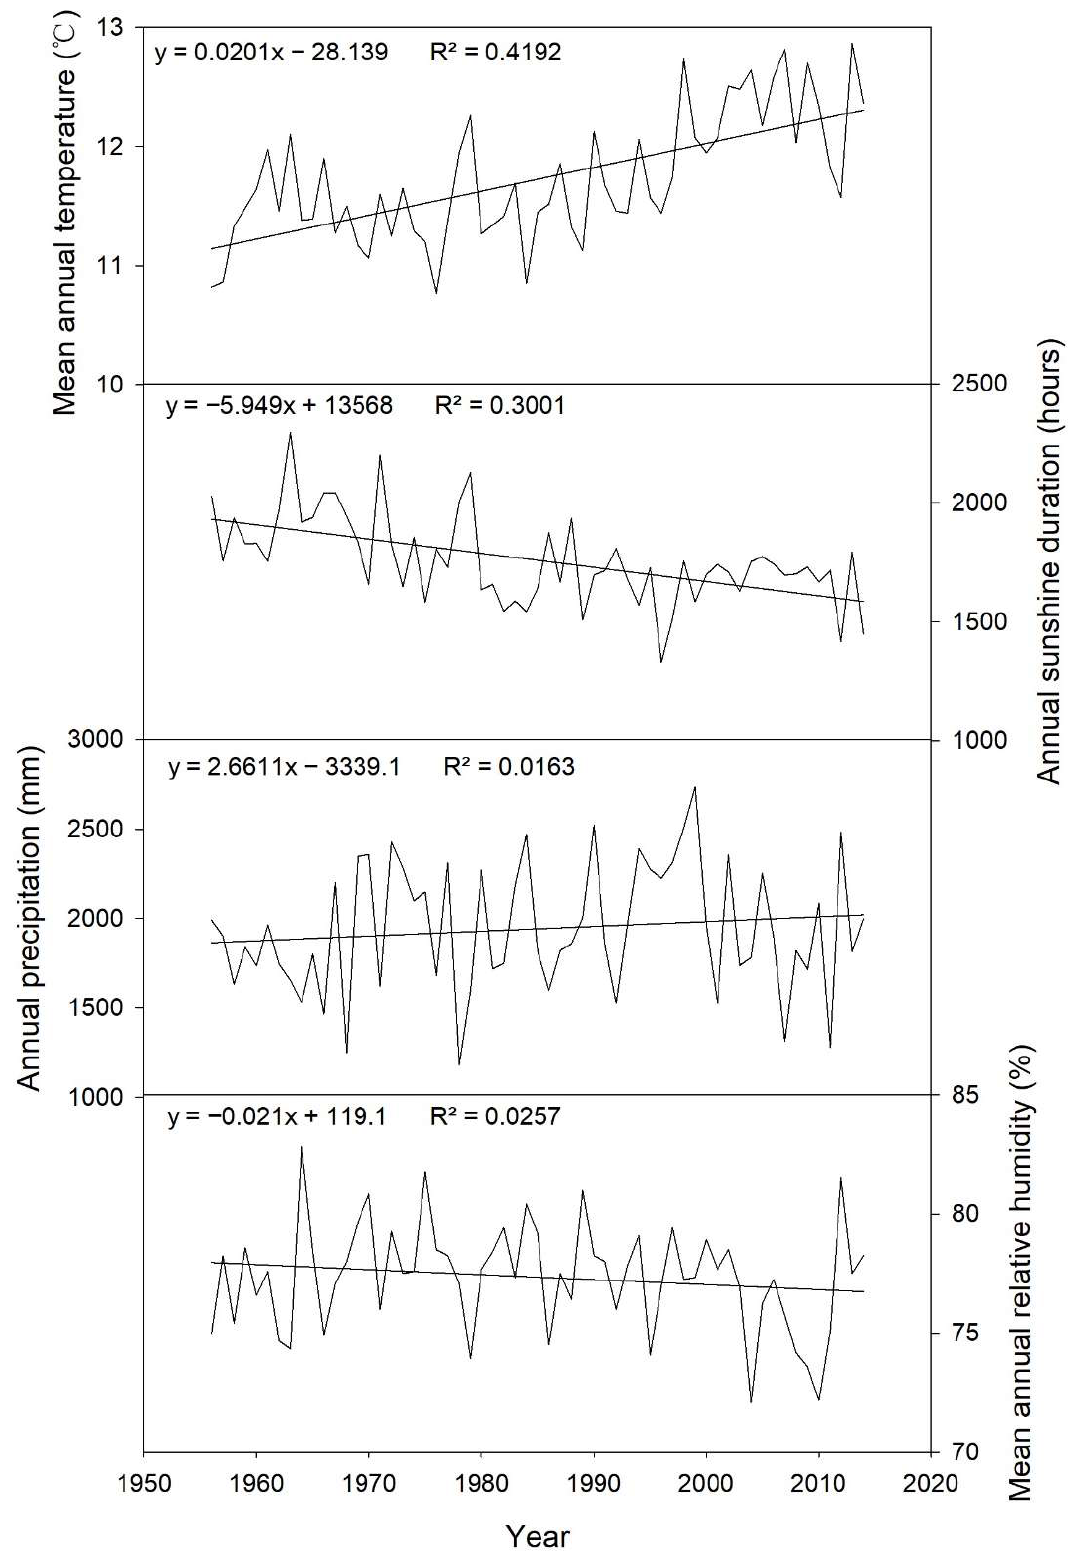
Figure 2. Trends of annual mean temperature, annual precipitation, annual sunshine hours, and annual mean relative humidity during 1955–2014.